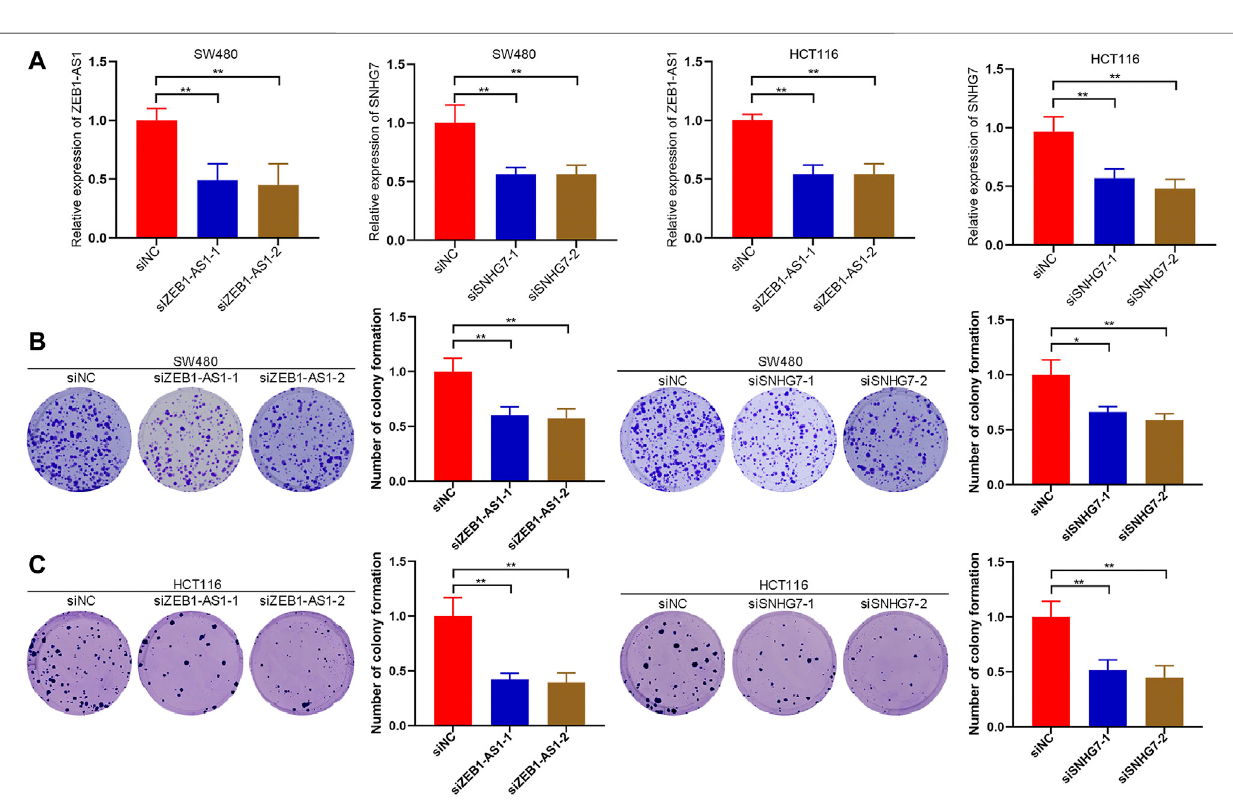
Frontiers in Genetics |